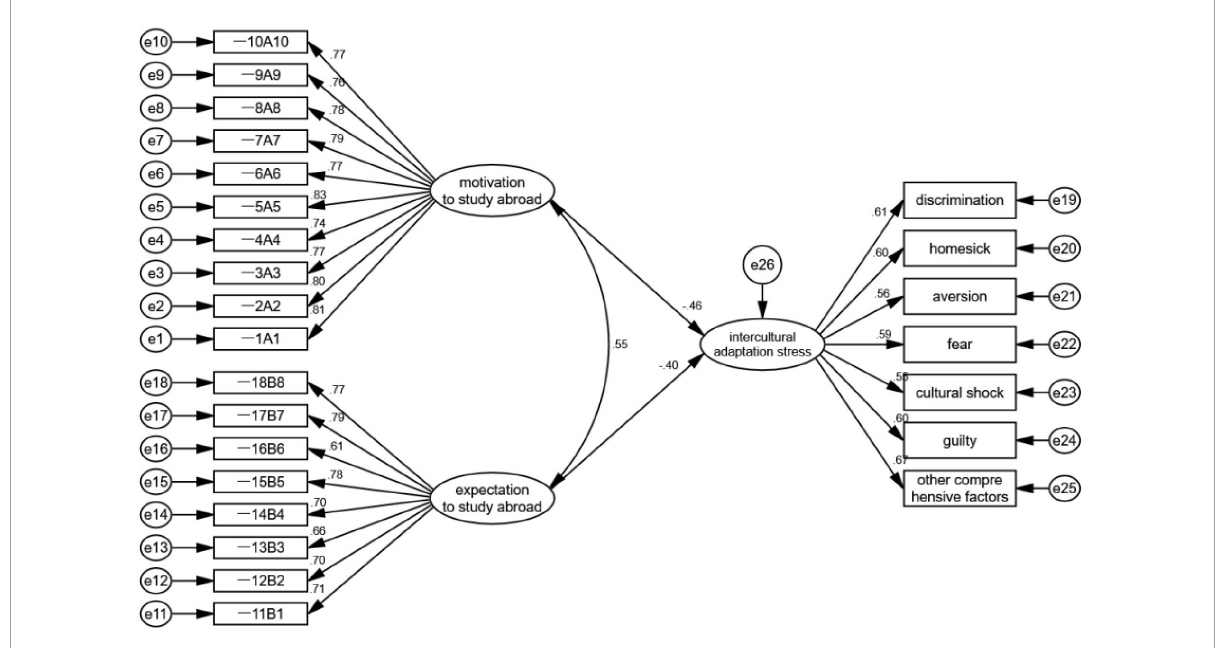
FIGURE1 Results of the operation of the structural equation model (SEM) diagram.